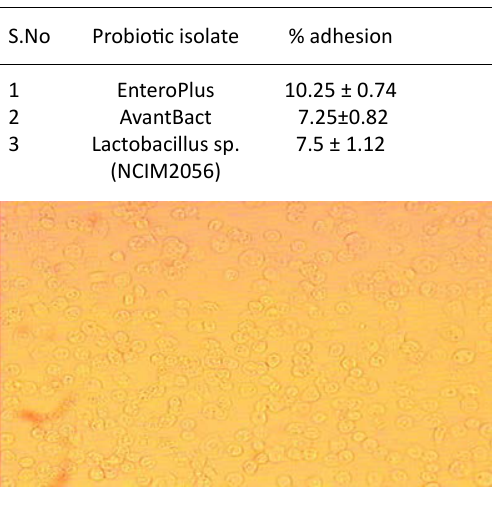
Fig. 1. Avant Bact. Caco cell line Fig. 2. Enteroplus Caco cell line